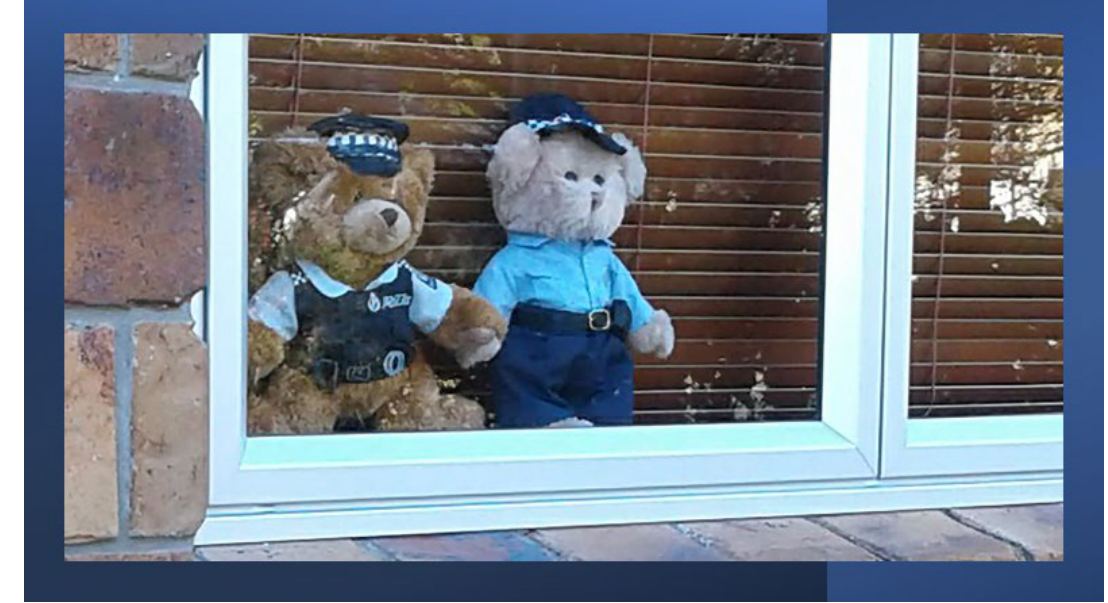
Figure 3. Police bears gazing out at the public. Image by the